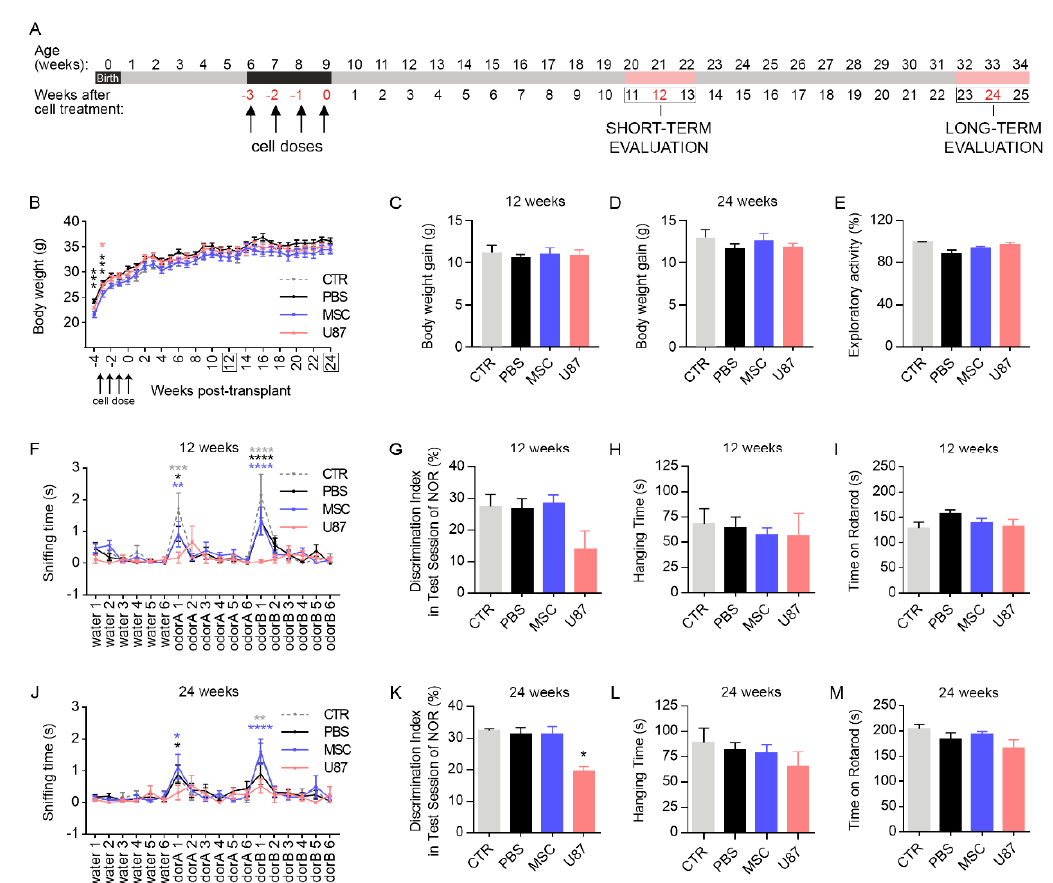
Figure 1. Intranasal delivery of MSCs does not induce changes in mice welfare and functional performance. ( A ) Treated mice received a dose of cells per week during 4 consecutive weeks (5·10 5 cells/dose). All analyses were conducted between week 11 and 13 for short-term studies (referred as 12 weeks to simplify) and between week 23 and 25 for long-term studies (referred as 24 weeks to simplify). ( B ) Body weight of the animals during the course of the experiment. n = 8–20 per group. Color code of the stats correspond to the color of each experimental group ( C ) Body weight gain at the short-term evaluation. n = 8–20 per group. ( D ) Body weight gain at the long-term evaluation. n = 8–16 per group. ( E ) Exploratory activity of mice prior initiating serial behavioral testing showing no differences between any experimental group. n = 4–11 per group. ( F ) Time spent sniffing the stimuli (water, odorA and odorB) in an odor discrimination task at the short-term, showing an impaired olfactory ability in U87 mice. Statistical analysis is performed to detect the change of stimuli (i.e., water 6 vs. odorA 1 and odorA 6 vs. odorB 1) and is indicated with color code corresponding to each experimental group. n = 4–13 per group. ( G ) Discrimination index between familiar and novel object (discrimination index = [time exploring the new object-time exploring the familiar object]/[time exploring the familiar object+ time exploring the new object] × 100) in the test session of the Novel Object Recognition (NOR) task at the short-term. n = 4–13 per group. ( H ) Wirehang test performance at the short-term. n = 4–13 per group. ( I ) Rotarod test performance at the short-term. n = 4–13 per group. ( J ) Time spent sniffing the stimuli (water, odorA and odorB) in an odor discrimination task at the long-term, showing an impaired olfactory ability in U87 mice. Statistical analysis is performed to detect the change of stimuli (i.e., water 6 vs. odorA and odorA 6 vs. odorB 1) and is indicated with color code corresponding to each experimental group. n = 4–13 per group. ( K ) Discrimination index between familiar and novel object (discrimination index = [time exploring the new object-time exploring the familiar object]/[time exploring the familiar object+ time exploring the new object] × 100) in the test session of the Novel Object Recognition (NOR) task at the long-term. n = 12–4 per group. ( L ) Wirehang test performance at the long-term. n = 4–12 per group. ( M ) Rotarod test performance at the long-term. n = 4–13 per group. Data are represented as mean ± SEM. * p < 0.05, ** p < 0.01, *** p < 0.001, **** p < 0.0001 compared to CTR group; Mixed-model ANOVA ( B ), Two-way repeated-measures ANOVA ( F , J ). One-way ANOVA ( C – E , G – I , K – M ). Mice were monitored after cell transplant to assess animal welfare during the whole study period, using the Welfare Quality ® protocol [29]. No significant differences were found in terms of good feeding, housing, health or appropriate behavior, except for mice receiving positive control cancer cells (i.e., U87 mice) (Supplemental Table S2). Over the